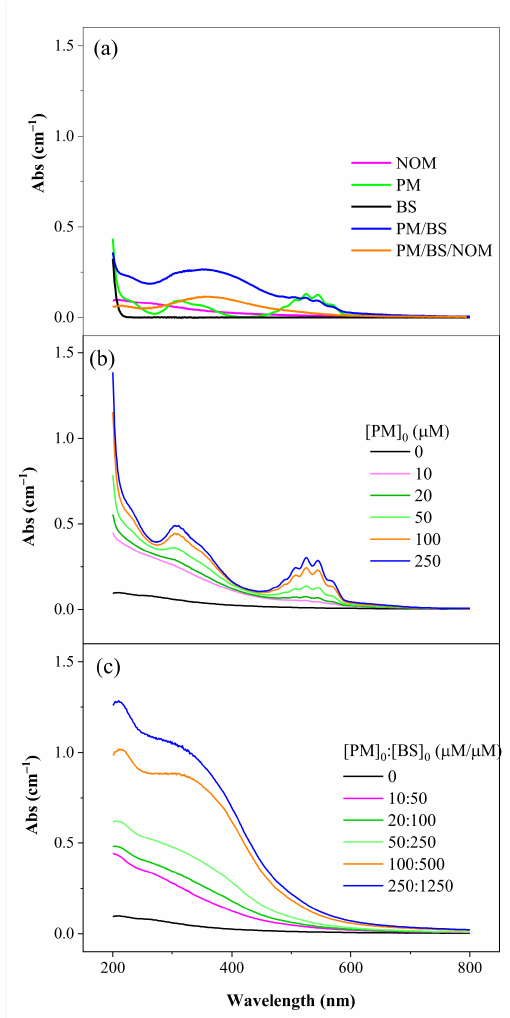
Figure 1. The UV-visible absorption spectra in different oxidation systems ( a ). ((HA) o = 3 mg L − 1 , (PM) o = 50 µ M, (BS) o = 250 µ M and t = 30 min). The UV-visible absorption spectra obtained from different PM ( b ) and PM/BS doses ( c ). ((HA) o = 3 mg L − 1 , (PM) o = 0–250 µ M, (BS) o = 0–1250 µ M and t = 30